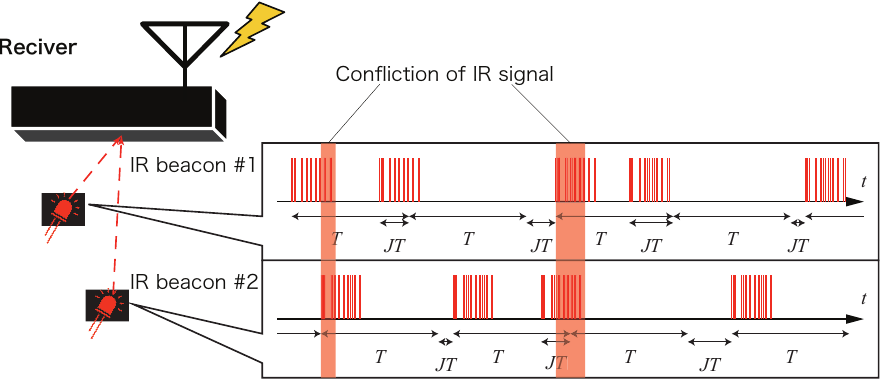
Figure 12. Data loss due to temporal conflict caused by increasing the number of beacons.